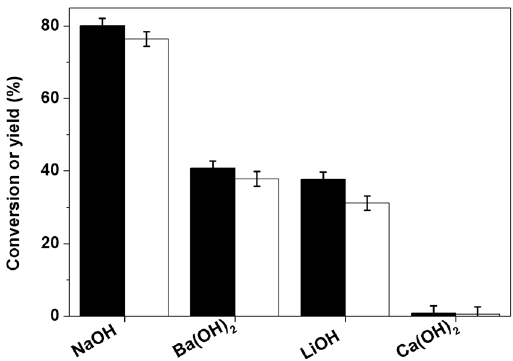
Figure 4. Conversion of compound 2 (black bars), the carbon yields of compound 4 (gray bars) over base catalysts. Reaction conditions: 443 K, 72 h; 20.0 g (0.143 mol) compound 2 , 50 mmol alkali hydroxide (or 25 mmol alkaline earth metal hydroxide) and 20 mL p